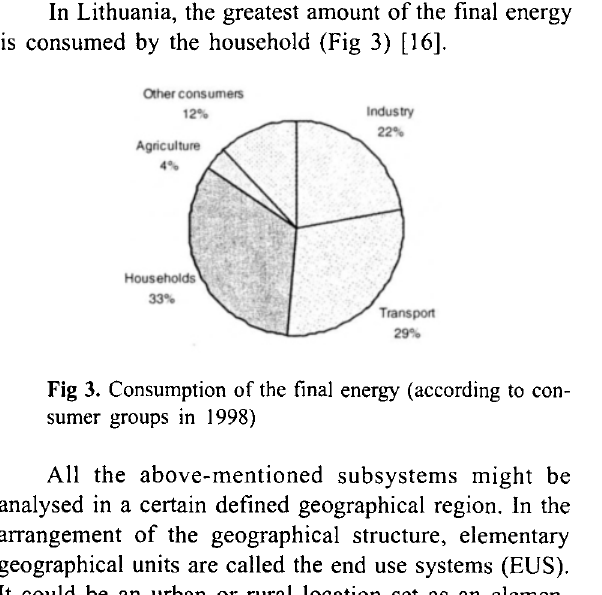
Fig 2. Regulation of energy planning in Lithuania The main documents [12-14] regulating the energy sector and setting the planning criteria are as follows: Law on Energy, National Energy Strategy and National Energy Efficiency Programme.